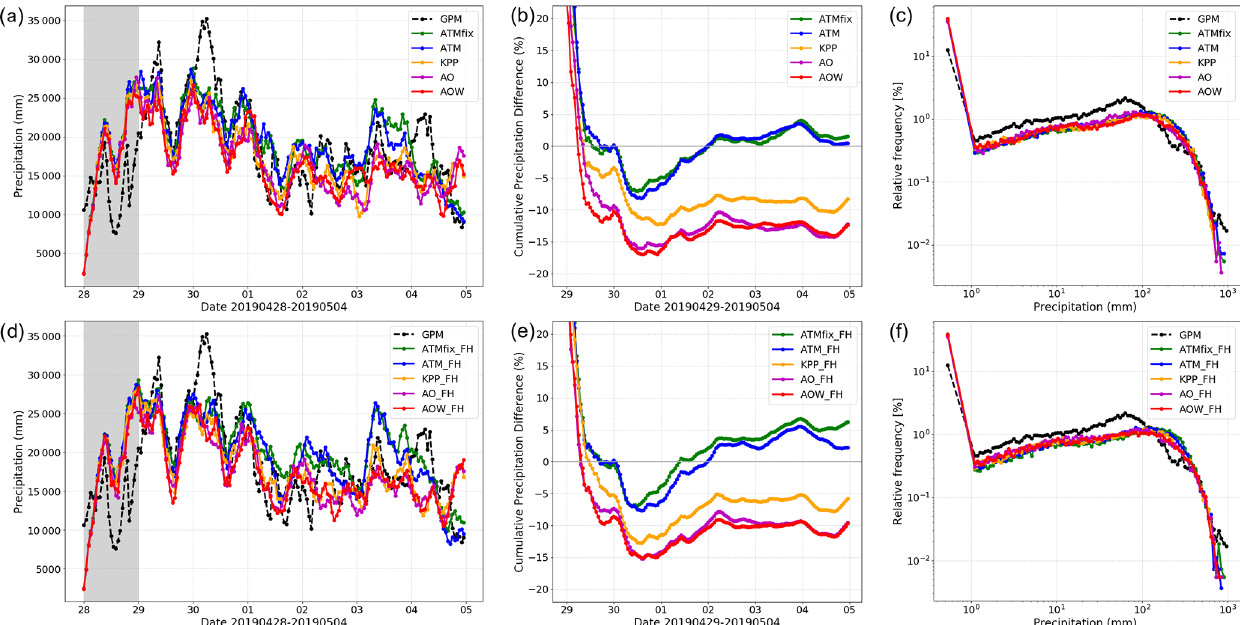
Figure 13. Comparison of Bay of Bengal sub-domain precipitation characteristics for Fani case study for simulations (a–c) without and (d–f) with frictional heating enabled. (a, d) Time series of sub-domain accumulated precipitation for region shown in Fig. 10. (b, e) Cumulative percentage difference between simulated precipitation and GPM observations, computed after day 1 of simulation to avoid spin-up effects. (c, f) Frequency distribution of 7d accumulated precipitation relative to